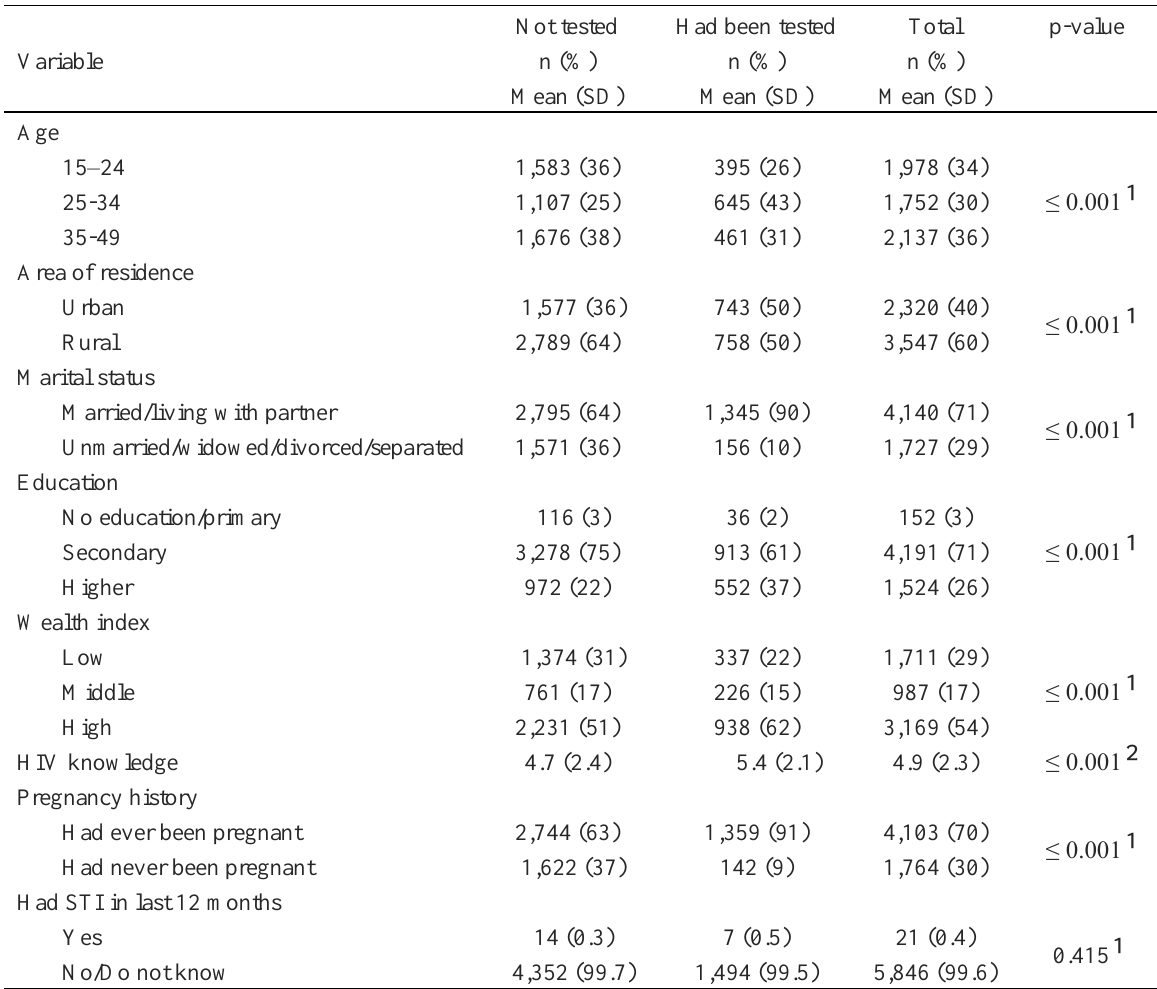
Table 1. Demographic and Socioeconomic Characteristics of Participants by HIV Testing History (n = 5,867)